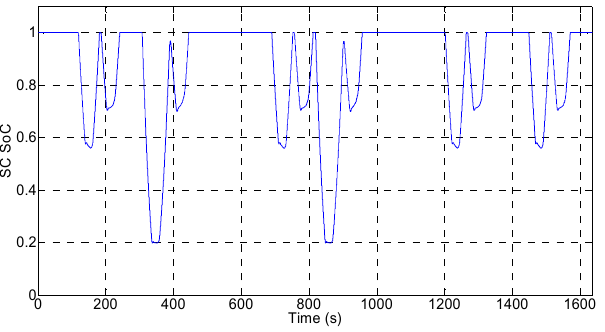
Figure 17. SoC of the SC under intermittent work.